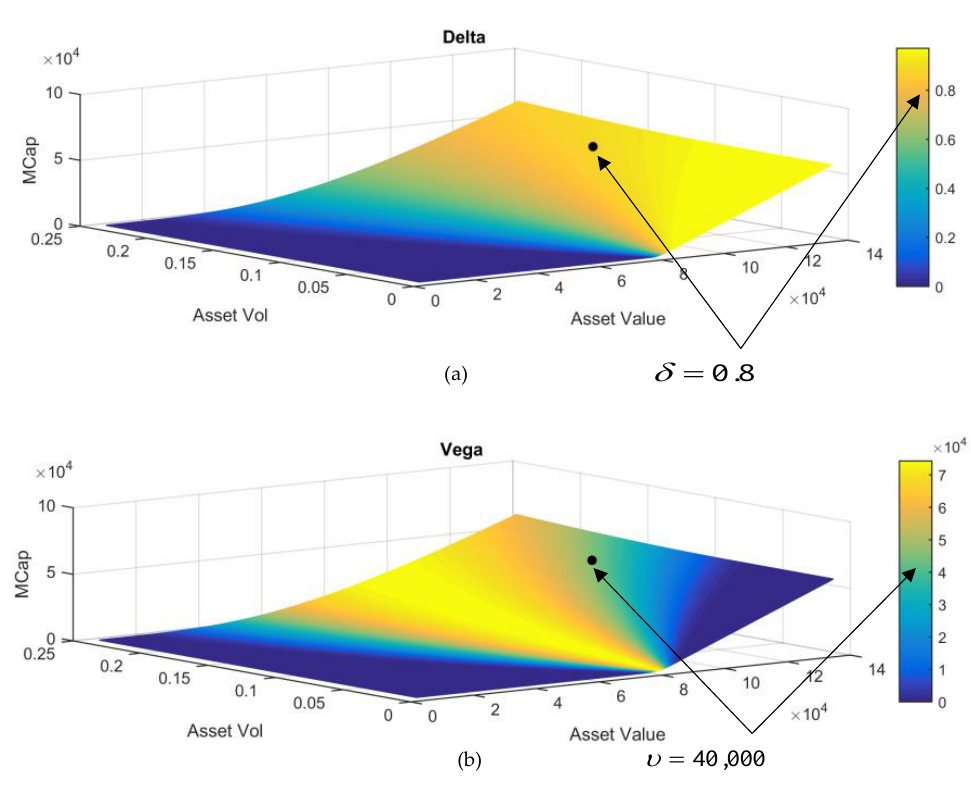
Figure 2. BMW sensitivities from Equation (3) for: ( a ) Delta, or δ = ∂ MCap AssetVolMCap where MCap is the Market Capitalization (in millions), Assets represents the asset value of the company (in millions) and AssetVol is calculated in equation (11) .